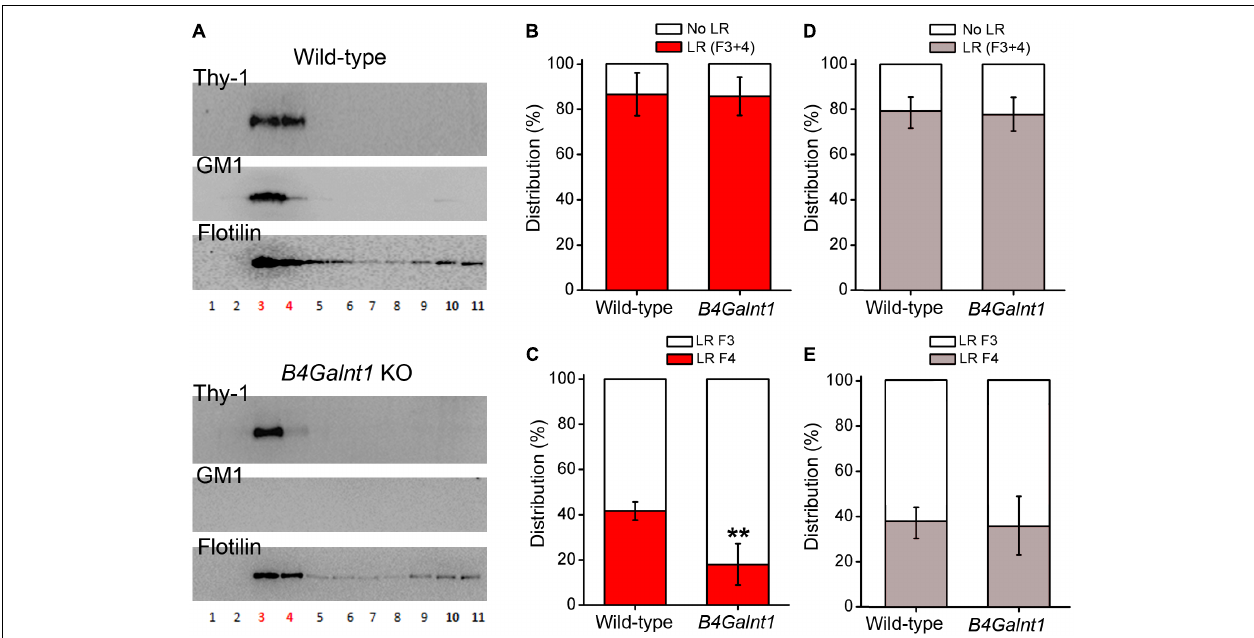
FIGURE 3 | Thy-1 distribution in sucrose density gradients of wild-type and B4Galnt1-null brain membranes. (A) Representative Western blots of sucrose gradient fractions obtained from total membrane homogenates of wild-type and B4Galnt1 KO brain cortices as indicated. Lipid rafts isolation is based on published protocols (Persaud-Sawin et al., 2009; Hattersley et al., 2013) with some modifications. After homogenization, nuclear fraction was removed and cell membrane pellet was obtained by centrifugation (30 min, 100,000 × g ). This pellet was further homogenized in a lysis buffer containing BrijO20 and ultracentrifuged at 140,000 × g in a discontinuous sucrose gradient (85% mixed with sample, 35 and 3%). Next day, all fractions were collected for analysis. B4galnt1 -null mice lacking GM2/GD2 synthase have been previously characterized (Takamiya et al., 1996, 1998; Sheikh et al., 1999; Chiavegatto et al., 2000; Li et al., 2008) and they cannot synthesize any of the four most abundant brain gangliosides GM1, GD1a, GD1b, and GT1b. We confirmed complete absence of GM1 (this Figure) and GT1b ( Supplementary Figure S1 ) in B4Galnt1 KO brain material using cholera toxin and specific primary antibodies, respectively. Isolation of lipid raft fractions (3 and 4 in red color) was confirmed by detection of flotilin. (B) Quantification of accumulative distribution of Thy-1 in bulk membrane fractions (F10 + F11, no lipid rafts: No LR) and in lipid raft fractions (F3 + F4, lipid rafts: LR) of each genotype. (C) Quantification of the distribution of Thy-1 in each of the two lipid raft fractions. Distribution of Thy-1 between the raft fractions 3 and 4 seems modified due to the alteration of ganglioside content in B4Galnt1 -null brain membranes ( ∗∗ P < 0.01 for fraction 4 comparing genotypes, Mann–Whitney test). (D) Quantification of accumulative distribution of flotilin was performed as for Thy-1 in (B) . (E) Distribution of flotilin between the raft fractions 3 and 4 was performed as for Thy-1 in (C) . Data are expressed as mean ± SD of 5 independent